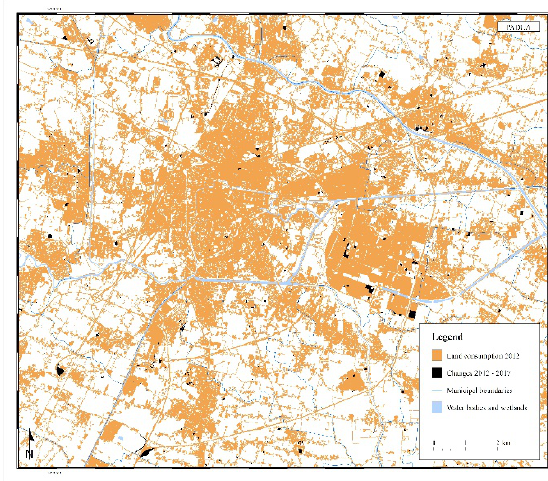
Figure 3. Soil consumption map of Padua (orange: soil consumption in 2012; black: soil consumption 2012 -